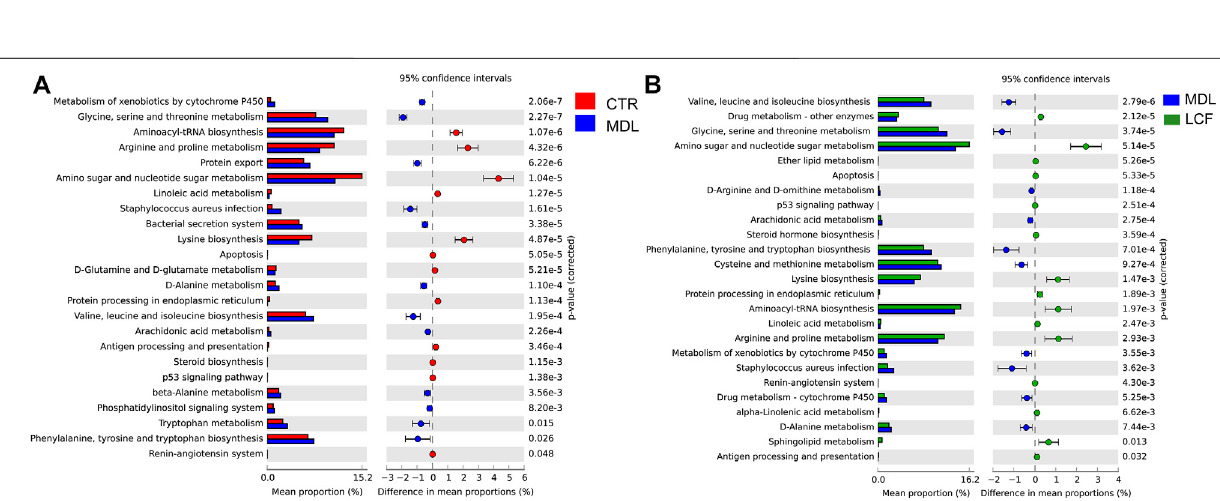
Frontiers in Pharmacology |